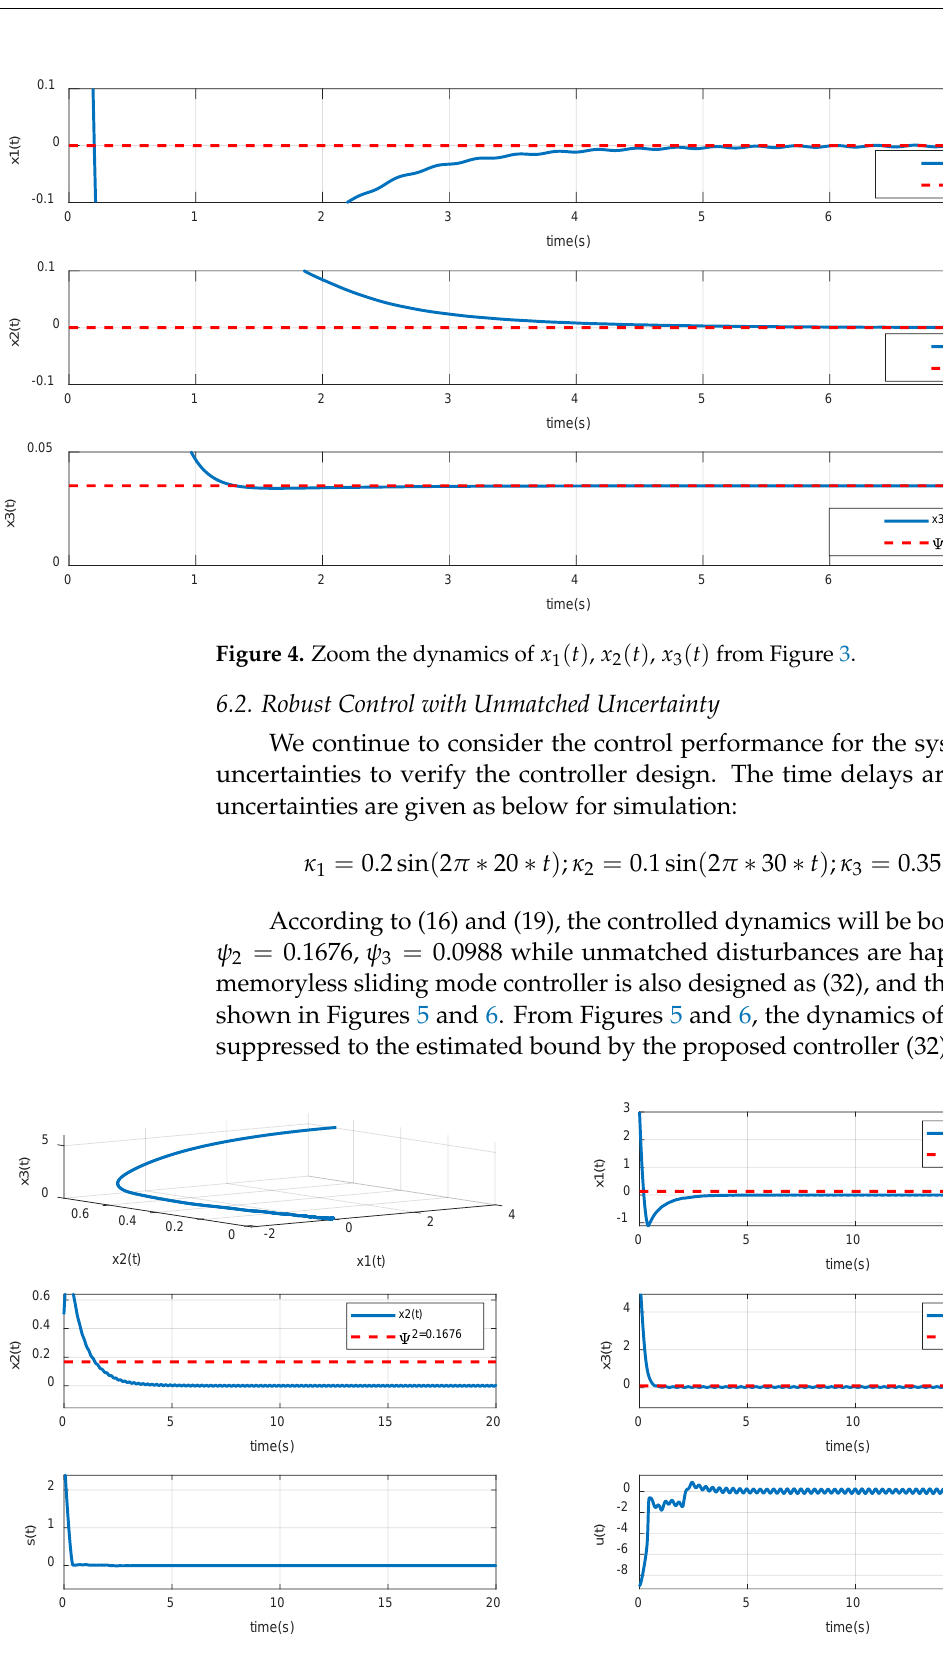
Figure 3. The system dynamics of controlled Rössler systems with unknown time delays and matched uncertainty.